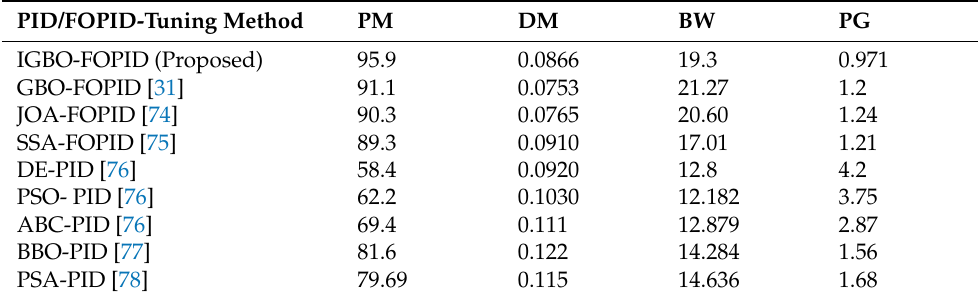
Table 15. Comparative AVR designs are based on stability evaluation indicators. PID/FOPID-Tuning